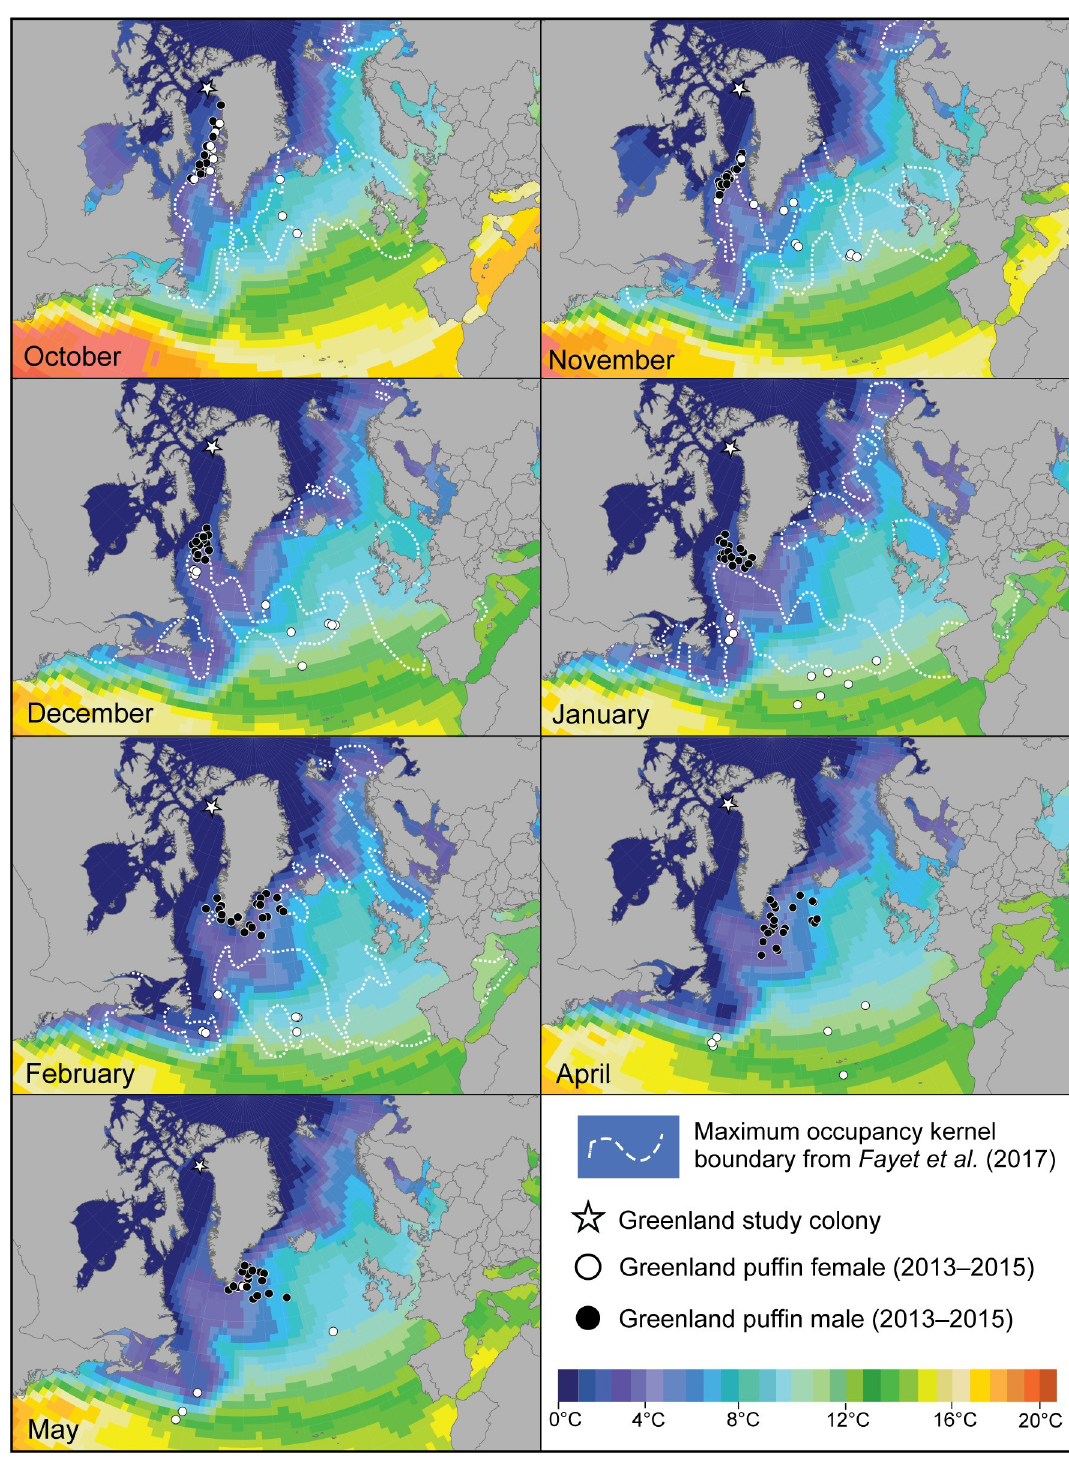
Fig 4. Atlantic puffin monthly winter range and sea surface temperature. Tri-monthly median locations of puffins from northwest Greenland and monthly puffin winter use areas from Fayet et al. [50] overlaid with 2013/14 average monthly sea surface temperatures [53]. No use area data for April/May was available from Fayet et al. [50] because puffins began returning to breeding colonies at that time, and no data for September or March for either study were available due to equinox periods. Country boundaries from [28].